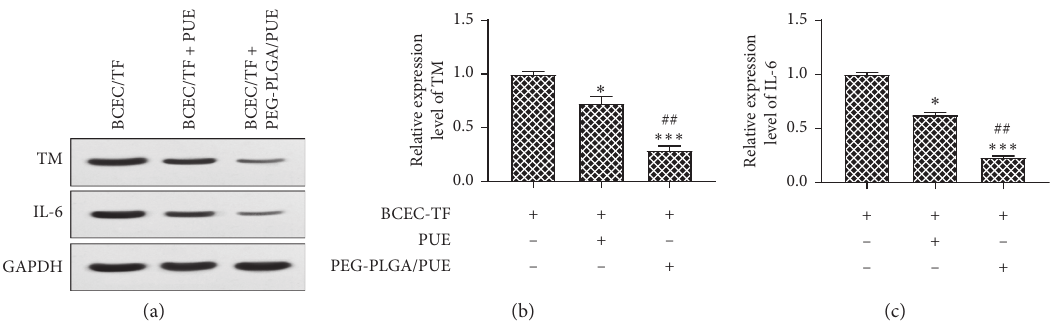
Figure 3: Expression levels of TM and IL-6 in BCEC/TF cells (data are shown by mean ± SD, N � 3; ∗ P < 0 . 05 and ∗∗∗ P < 0 . 001 vs. BCEC/TF group; ## P < 0 . 01 vs. PUE+BCEC/TF